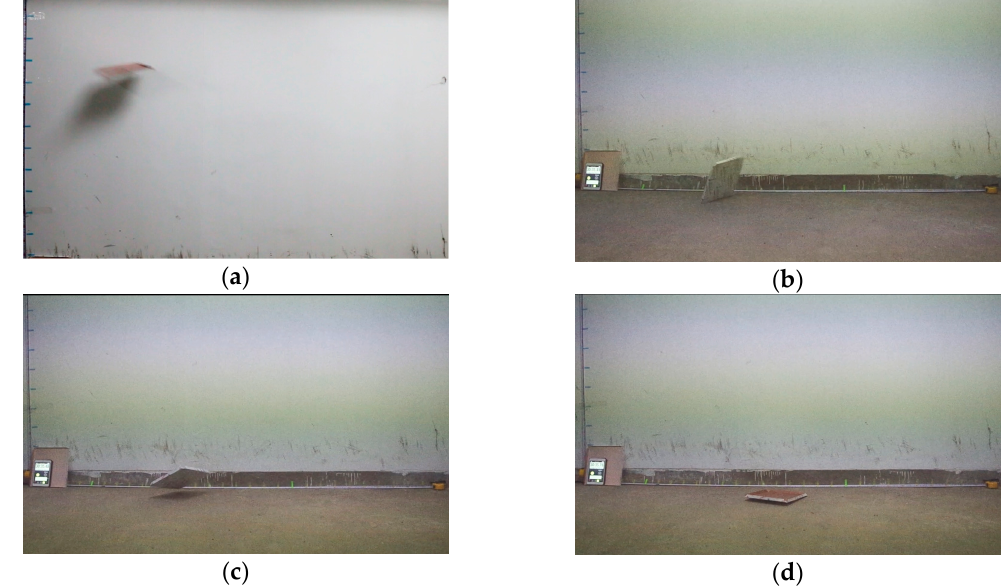
Figure 4. Falling process of a ceiling tile in the experiments, ( a ) projectile motion; ( b ) collision; ( c ) bounce; ( d ) slide.